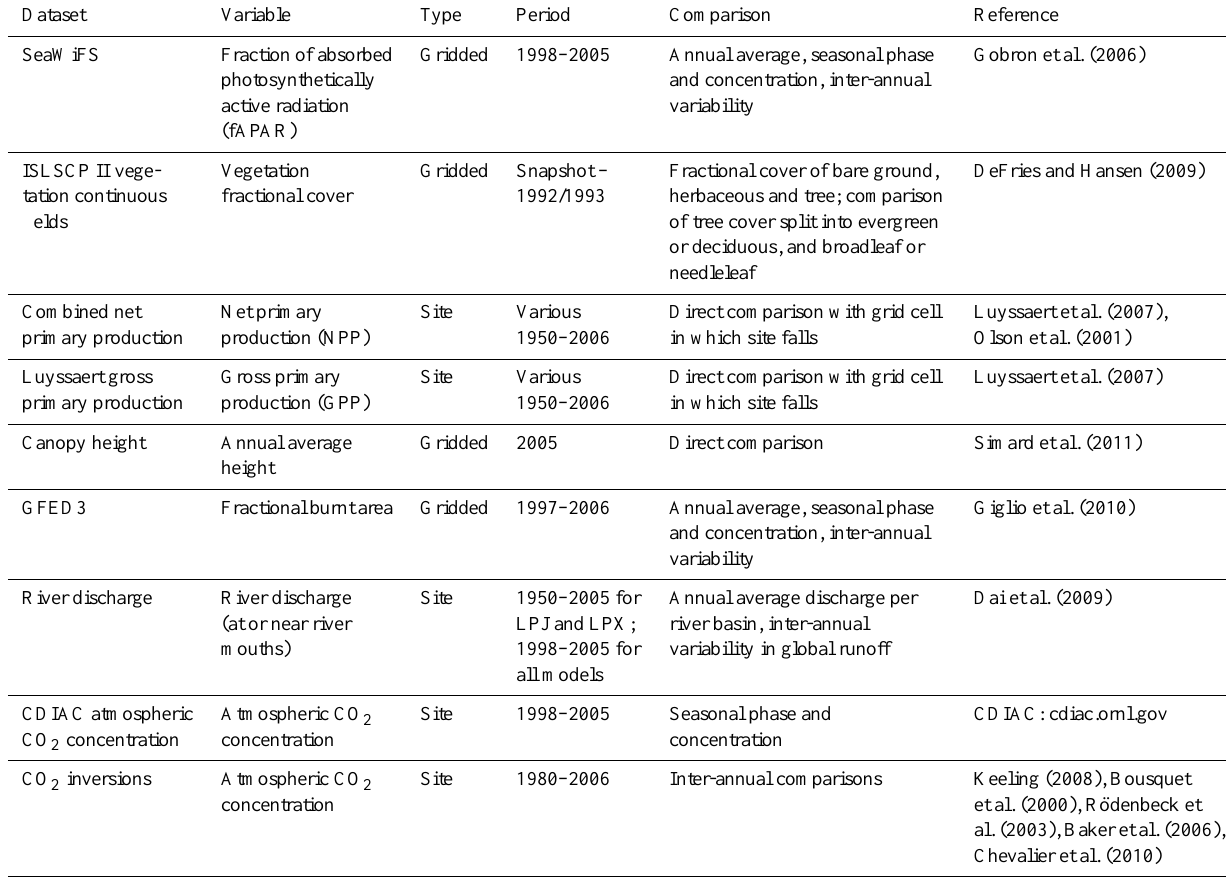
Table 1. Summary description of the benchmark